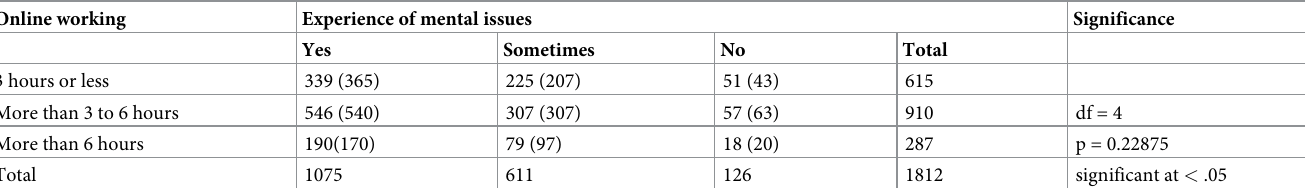
Table 3. Frequency of mental health issues experienced and number of online working hours.